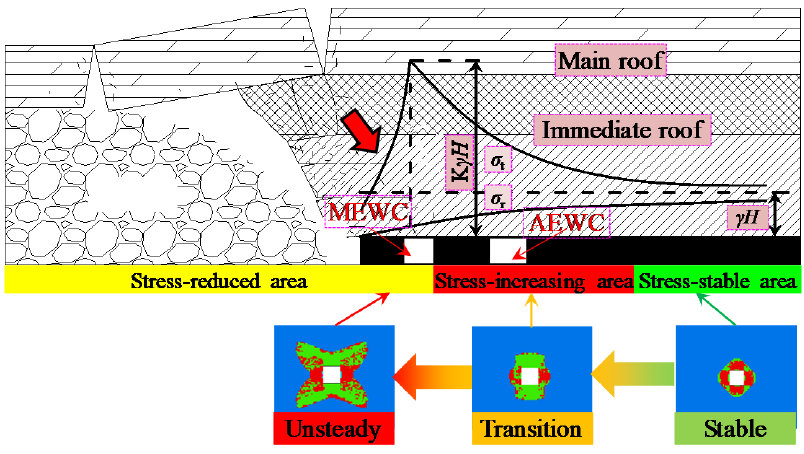
Figure 18. Relationship between mining stress and the plastic zone.